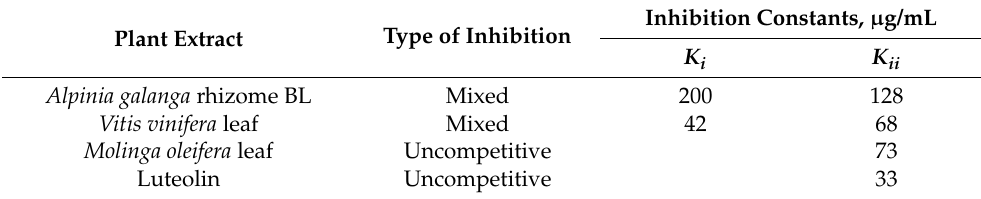
Table 2. Inhibition of TYR diphenolase by plant extracts. Plant Type of Inhibition